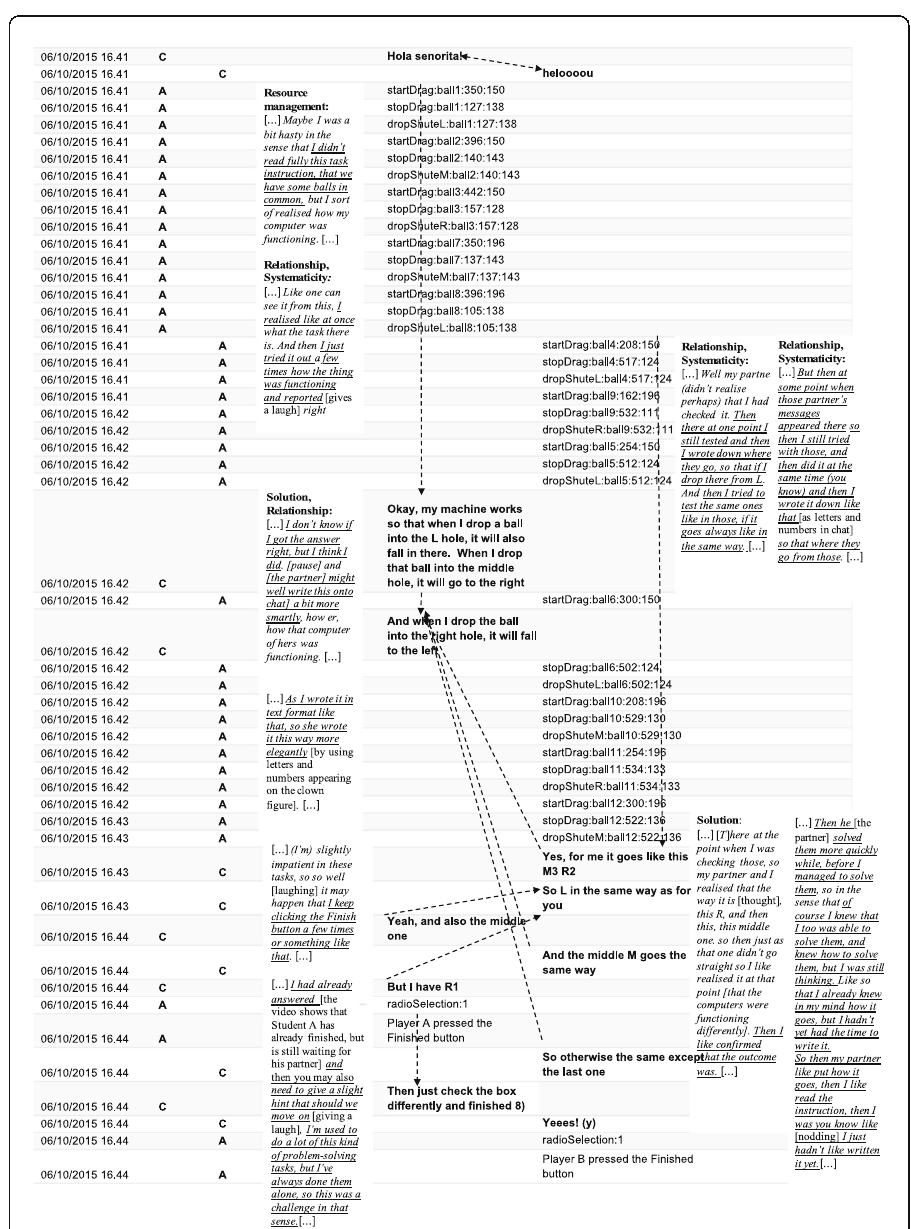
Fig. 11 The full episode of pair 29 (individual solution endeavour) in the Laughing Clowns